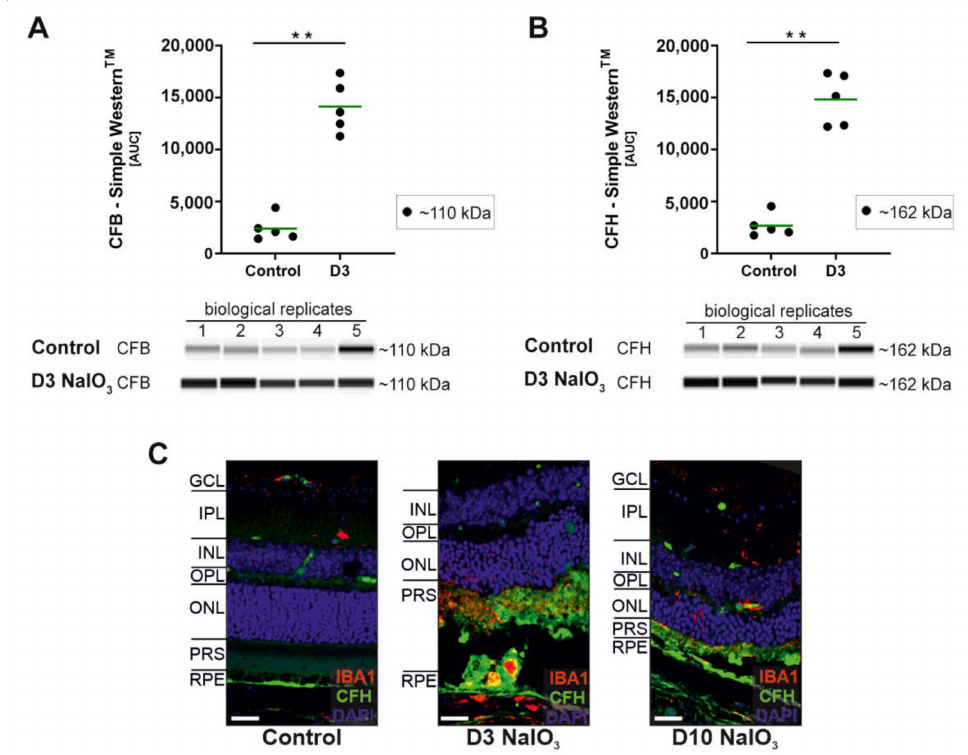
Figure 5. Alternative pathway component CFB and CFH protein levels were increased after the NaIO 3 treatment. ( A ) The CFB (~110 kDa) protein levels were increased at day 3 after the NaIO 3 treatment in all the samples compared to an untreated control using Simple Western TM technology for detection. ( B ) Complement inhibitor CFH (~162 kDa) accumulated in the neurosensory retina of NaIO 3 -treated mice compared to the control. ( C ) Retinal degeneration using NaIO 3 resulted in CFH deposition in the photoreceptor outer segment layer shown in immunohistochemical stainings. An overlapping with microglia marker IBA-1 was observed. ( A , B ) GAPDH was used as a housekeeping protein. The intensity of the protein signal was measured using ImageJ software. ** 0.001 < p < 0.01 (unpaired, nonparametric Mann–Whitney t -test). The full blots are shown in Supplementary Figure